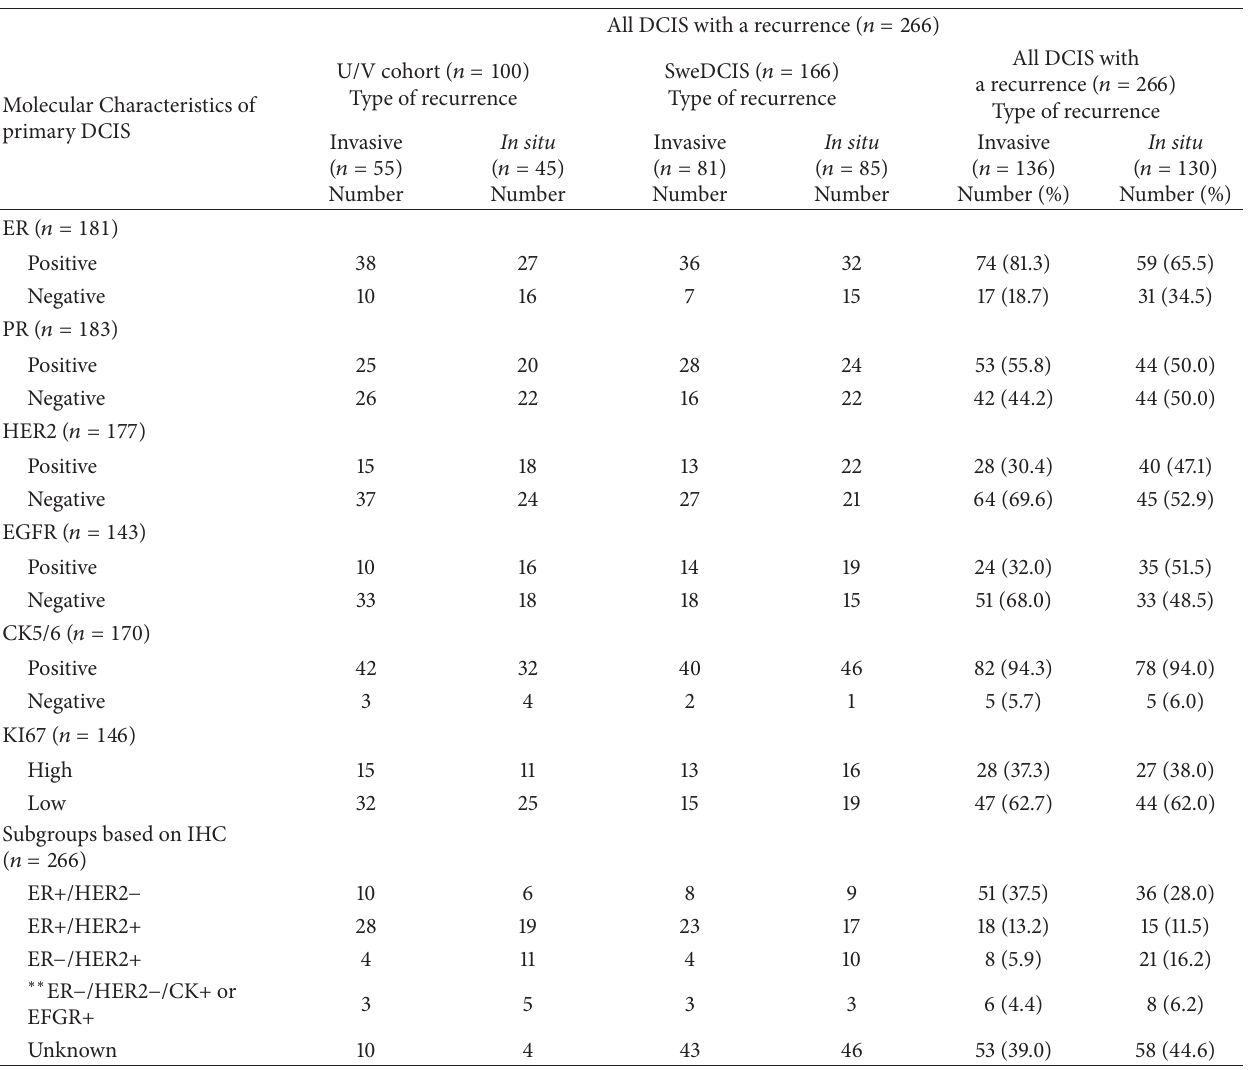
Table 2: Molecular characteristics among women with a primary DCIS who later developed either an invasive cancer or an in situ recurrence. Women with a known recurrence were recruited from two source populations: a population based cohort (U/V cohort, 𝑛 = 458 ) and a randomized study (SweDCIS, 𝑛 =